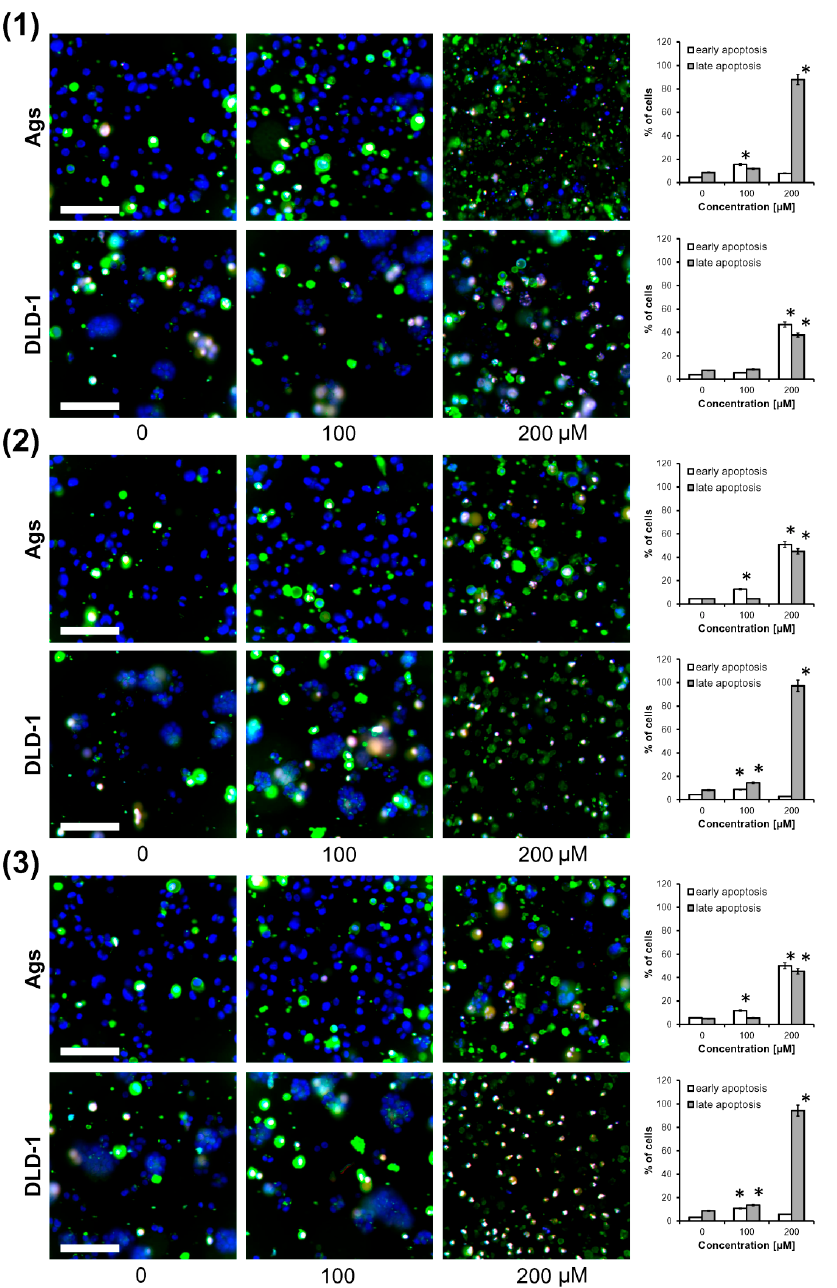
Figure 3. Triterpene seco -acids promote apoptosis in AGS and DLD-1 cells. AGS and DLD-1 cells treated with 3,4- seco -urs-4(23),20(30)-dien-3-oic acid ( 1 ), 3,4- seco -olean-4(24)-en-19-oxo-3-oic acid ( 2 ), and 3,4- seco -urs-4(23),20(30)-dien-19-ol-3-oic acid ( 3 ) for 24 h were triple stained with annexin V-FITC conjugate (green fluorescence), propidium iodide (red fluorescence), and Hoechst 33342 (blue fluorescence), and were visualized by fluorescence microscopy. Representative merged photographs are shown. Scale bar = 100 μ m . Data are presented as mean ± standard deviation (SD) from three assays. * p < 0.05 compared to control group.